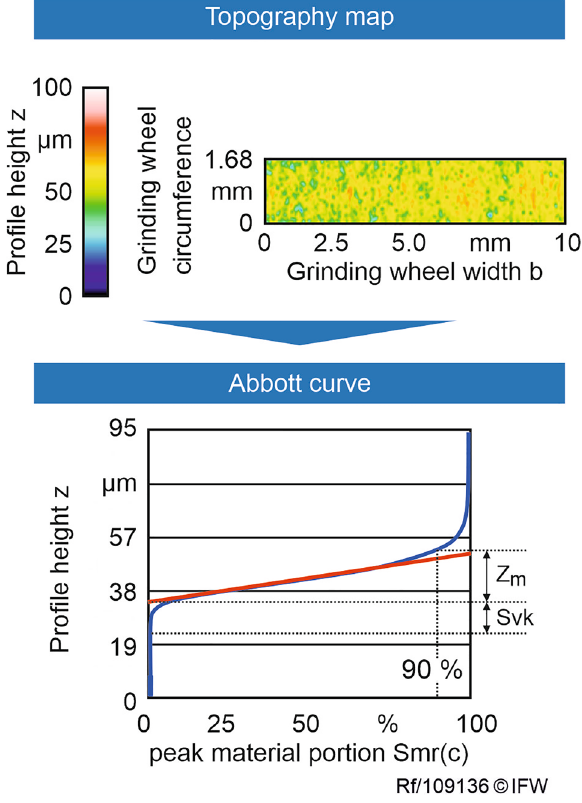
Fig. 2 Calculation of the mean grain protrusion from the Abbott curve of a topography map